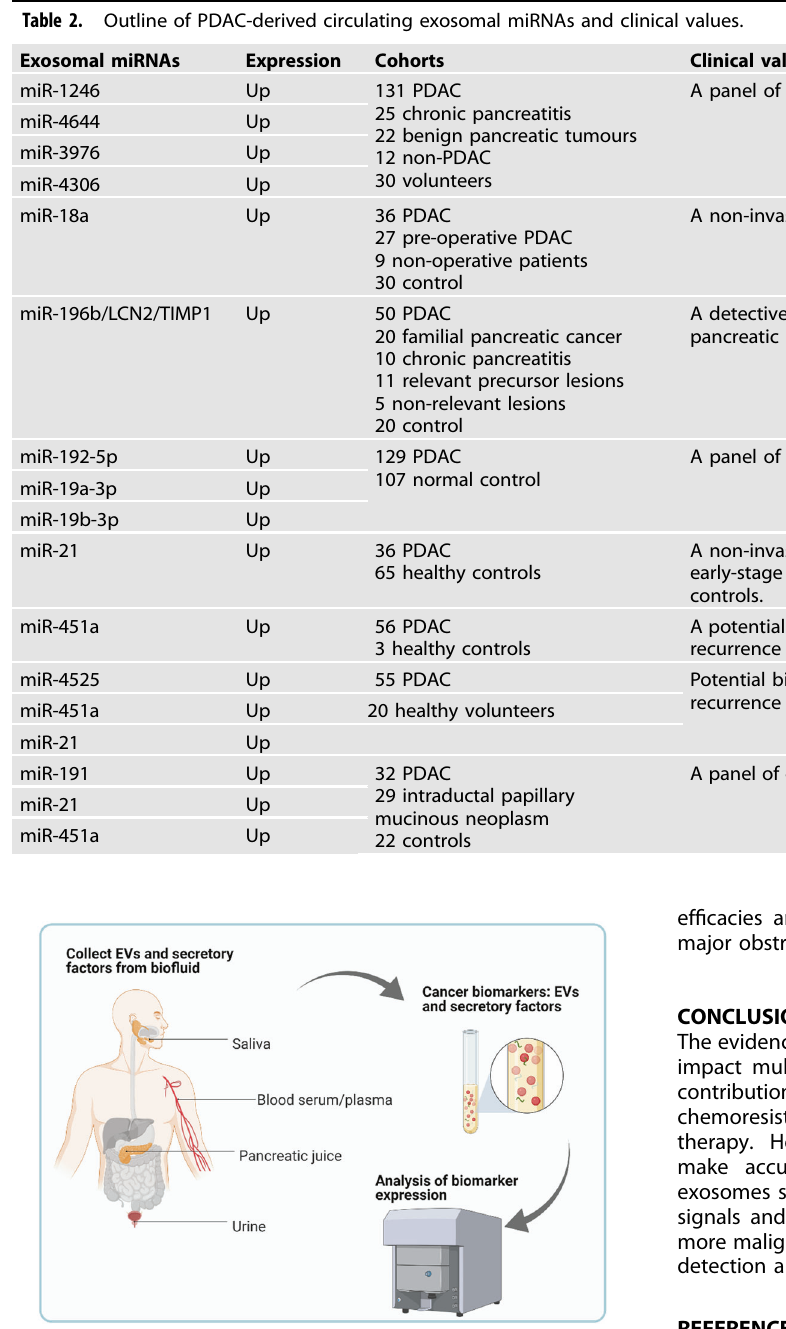
Fig. 3 Future perspectives of PDAC early detection and diagnosis. EVs isolated from bio fl uid, including saliva, peripheral blood serum or plasma, pancreatic juice, and urine, provide speci fi c exosomal protein and miRNA pro fi ling that can distinguish PDAC patients and healthy donors. Combination of novel exosomal factors (e.g. exosomal glypican-1) and known PDAC markers, such as CA19-9 from serum, provide new strategies for earlier and more reliable PDAC diagnosis.